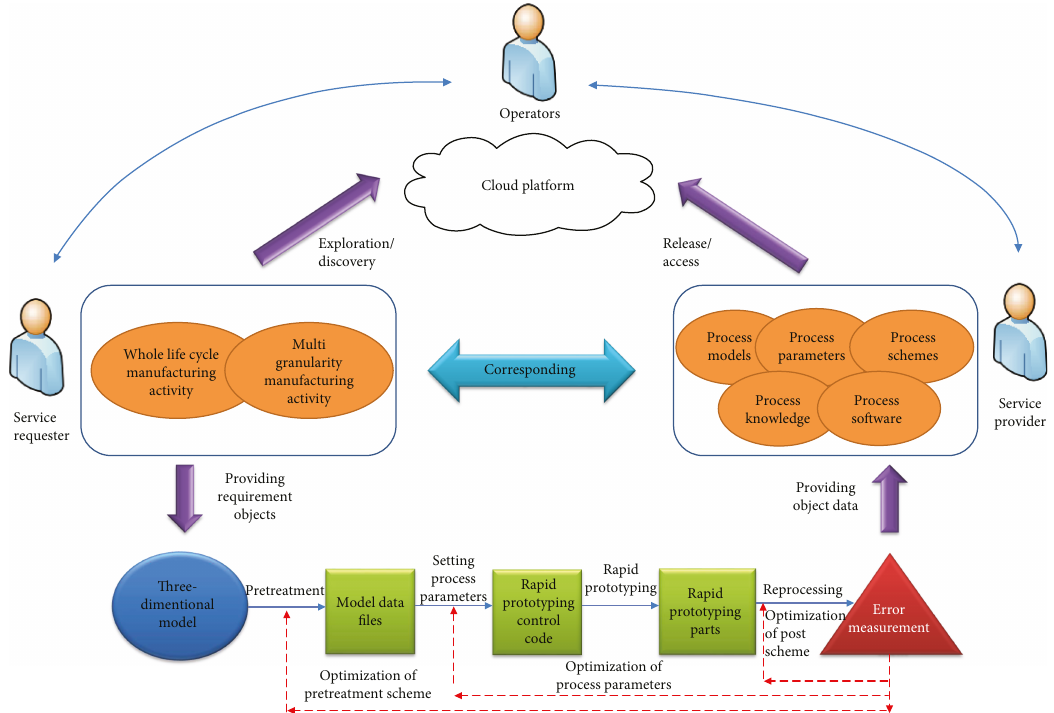
Figure 1: The intelligent manufacturing system of the FDM rapid prototyping complex-shaped mould based on the big data management of cloud